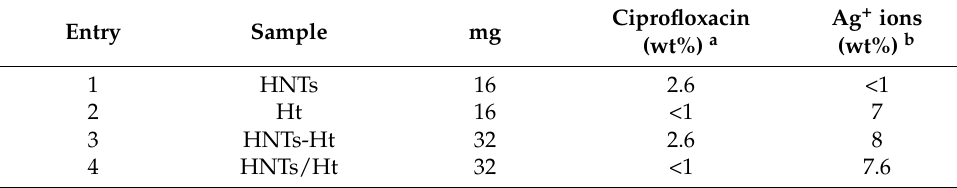
Table 3. Adsorption ability of HNTs, Ht and HNTs-HT towards ciprofloxacin and Ag +